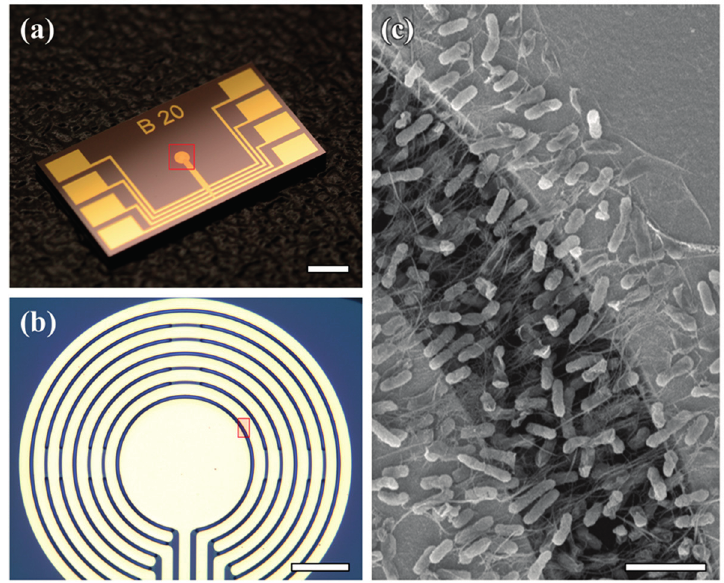
Figure 3. Device Imaging. Optical image of ( a ) the entire device (scale bar: 2 mm) and ( b ) a magnified view of the circular comb drive-shaped electrodes (scale bar: 50 µm). ( c ) SEM image of E. coli- attached SWNT film (scale bar: 5 µm). The red square in (a) indicates the image area of (b), and the red square in (b) indicates the image area of